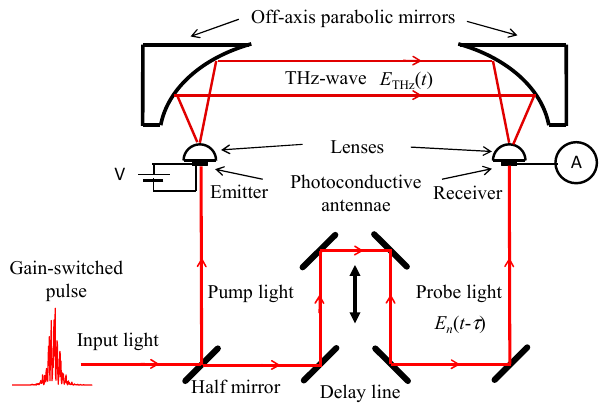
Figure 8. ( a ) Two-mode light spectrum; ( b – d ) examples of different input temporal waveforms and ( e – g ) corresponding optical beat outputs.